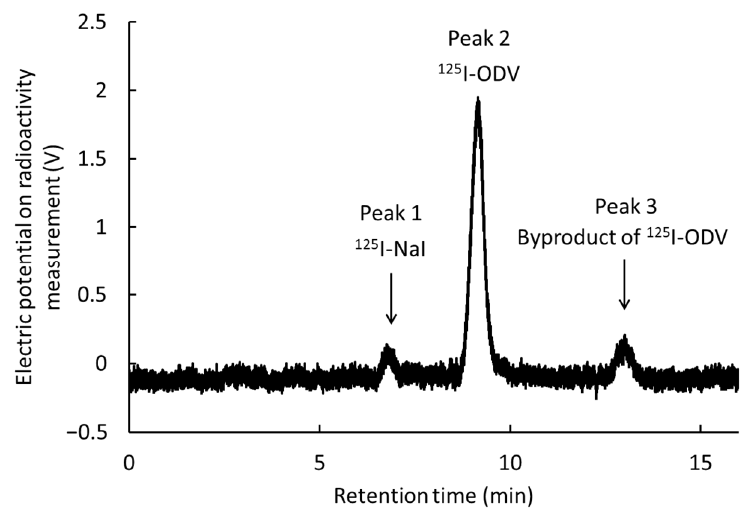
Figure 1. HPLC analysis of 125 I-ODV. The chromatogram shows peaks 1 − 3.